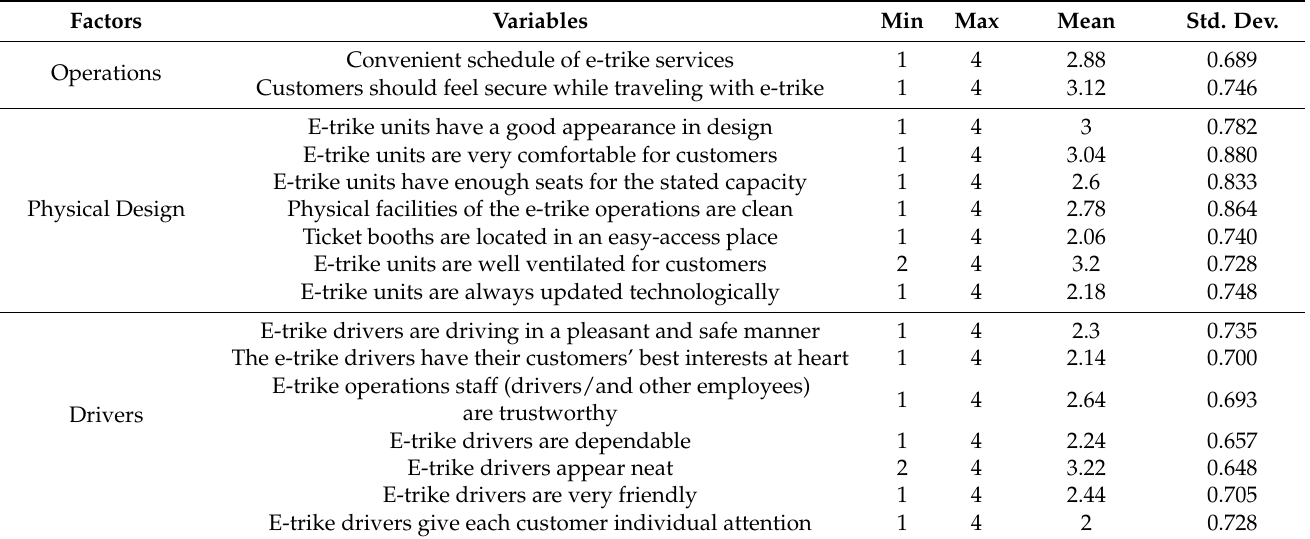
Table 7. Summary response to service quality